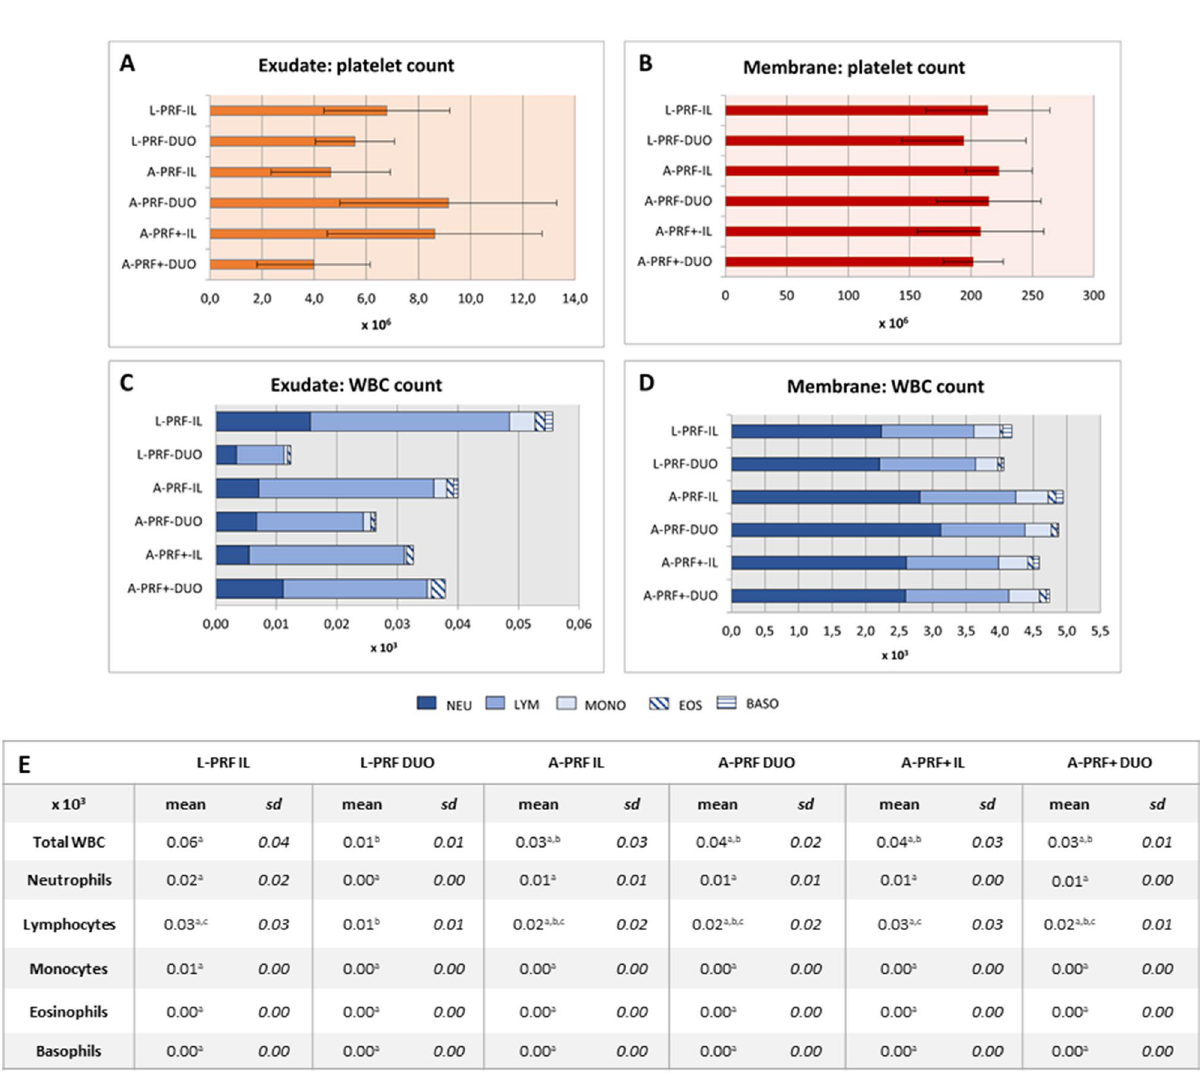
Figure 2. Cellular counting of the exudate and the membranes for each protocol. ( A ) Platelet count for exudate; ( B ) platelet count for membrane; ( C ) white blood cell count for each exudate; ( D ) white blood cell count for each membrane; ( E ) mean and standard deviation ( sd ) of the white blood cells count for the exudate. For each cell type, different letters (a–c) indicate statistical significant difference ( p > 0.05) between